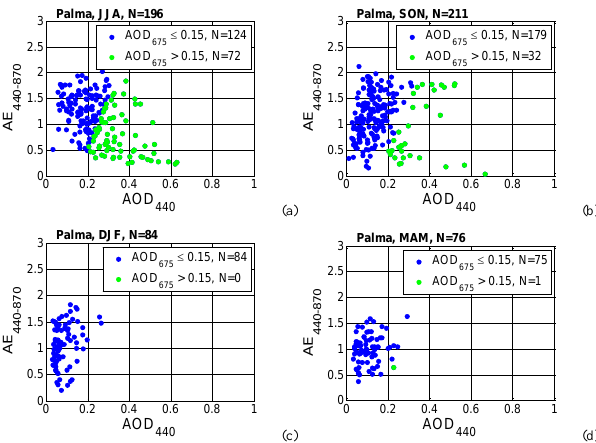
Figure 3. Ångström exponent calculated between 440 and 870nm (AE 440 − 870 ) as a function of the aerosol optical depth at 440nm (AOD 440 ) at Palma during (a) summer, (b) autumn, (c) winter and (d) spring, for the whole 2011–2015 AERONET level 2.0 daily AOD dataset. Blue bullets are for AOD 675 ≤ 0.15 and green bul- lets for AOD 675 >0.15.